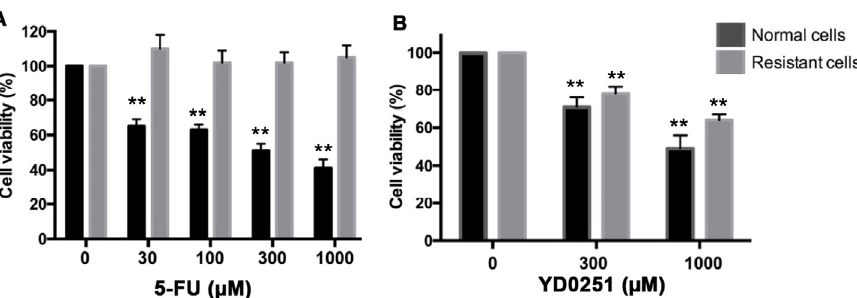
Figure 8. The inhibitory effect of YD0251 on cell viability is largely maintained in multidrug-resistant HCT116 cells. HCT116 cells were maintained in a 5-FU-containing medium for 2 months. Cell assumed a drug-resistant phenotype and lost their responsiveness to 5-FU ( A ), as assessed by the MTT assay 24 h after incubation with various concentrations of YD0251. ( B ) YD0251